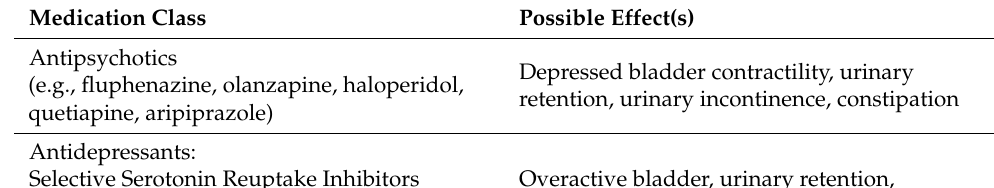
Table 5. Medication classes and possible effects on pelvic organ